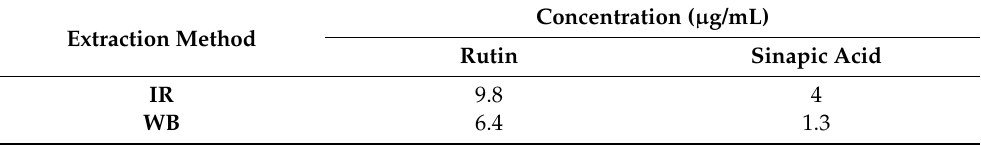
Table 4. Phenolic compounds concentrations ( µ g/mL) in IR and WB Eryngium creticum leaf extracts.